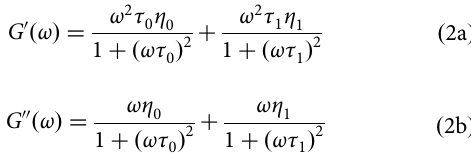
dangling or loosely associated macromolecules to tightly asso- ciated ones (Fig. 3b).